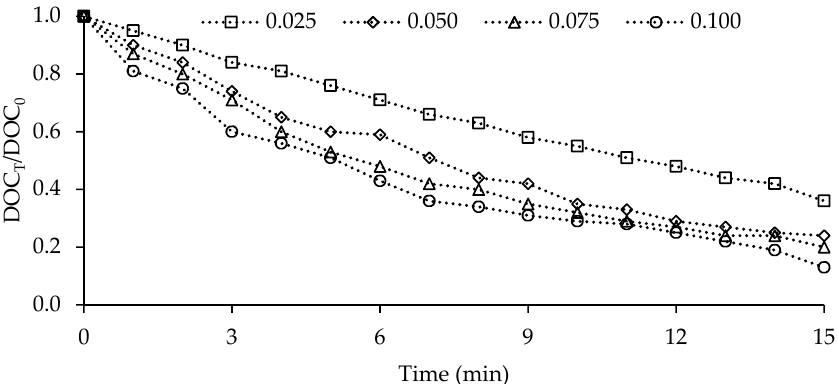
Figure 7 . Effect of catalyst dosage on the performance of catalytic ozonation (Catalyst dosages are given in g L − 1 , [O 3 ] = 10 mg L − 1 , [HA] = 10 mg L − 1 , pH = 6.8 ± 0.4, n = 600 rpm).